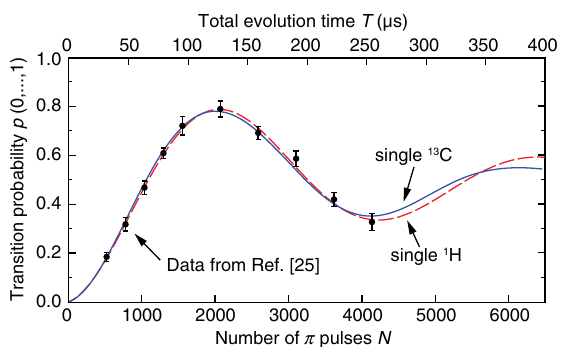
FIG. 7. Peak transition probability with increasing total evo- lution time T ¼ N τ measured at the expected 1 H resonance. Black data points are taken from Ref. [25]. The red dashed curve shows simulation for a single 1 H spin with coupling constant a = 2 π ¼ 14 kHz. The blue solid curve shows simulation for the ⊥ fourth harmonic of a single 13 C spin with a coupling constant a = 2 π ¼ 150 kHz. The pulse sequence is XY 8 . Further param- ⊥ eters are B ¼ 182 mT, ω 1 = 2 π ¼ 25 MHz, and τ ¼ 61 . 5